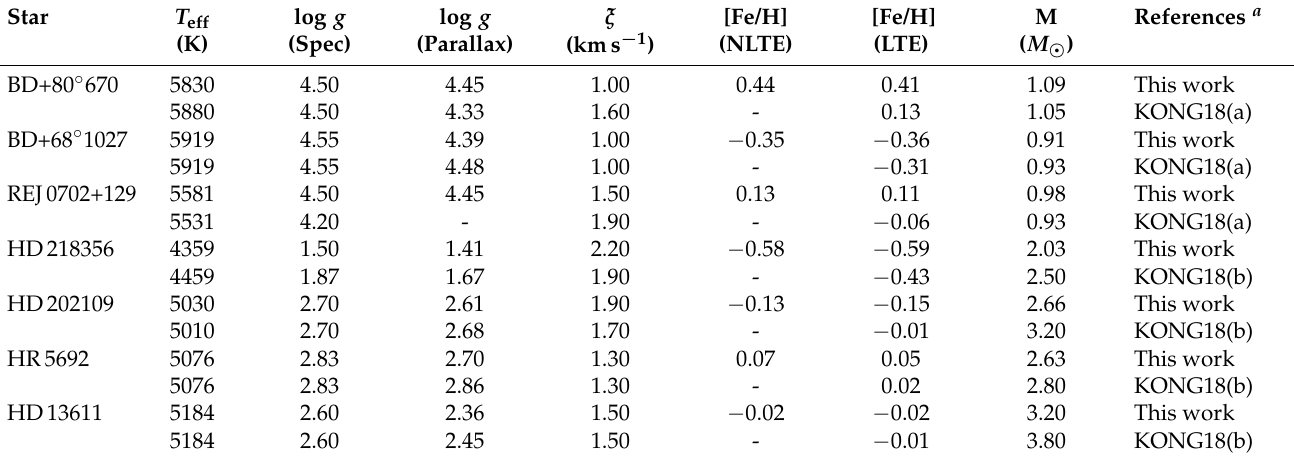
Table 2. The stellar atmospheric parameters and masses of our sample stars.